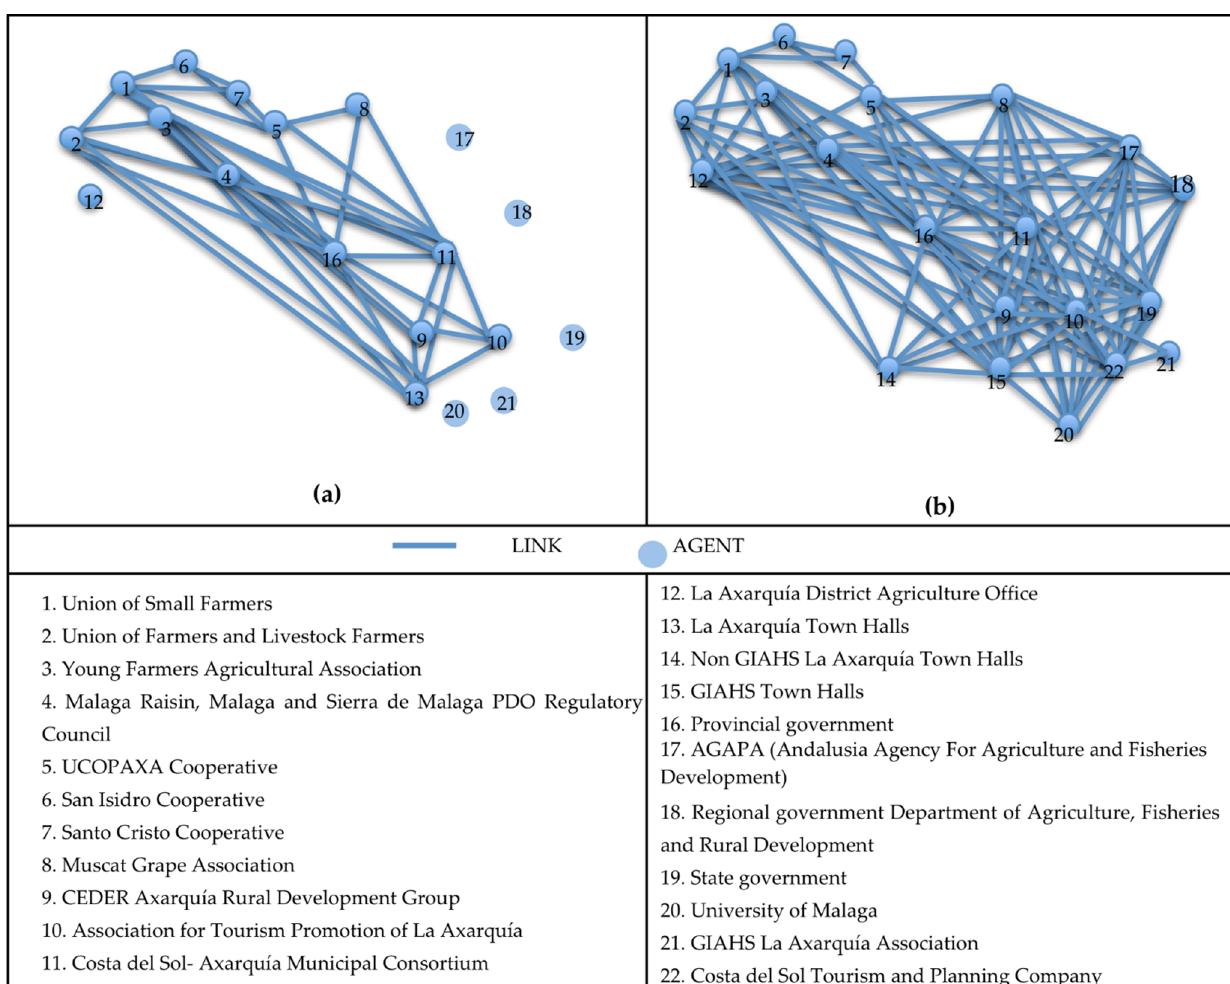
Figure 10. Social capital in La Axarquía (stakeholders, institutions and administrations, and links): ( a ) Before GIAHS; ( b ) After GIAHS. Source: Prepared by authors.